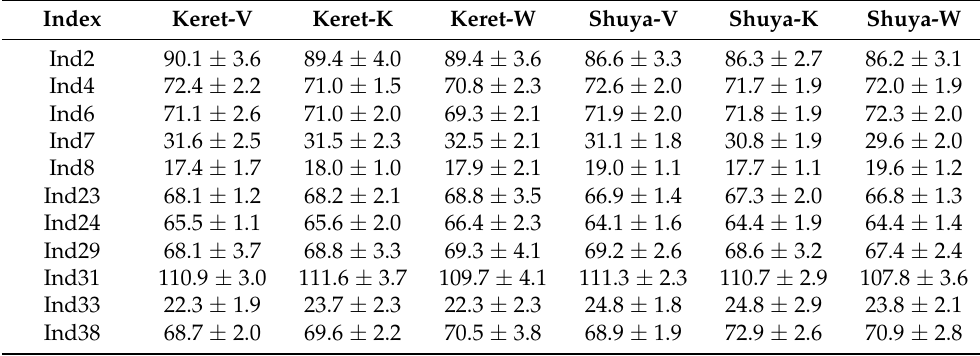
Table 3. Mean cranial bone indices (mean ± std. dev.) in the six juvenile Atlantic salmon samples examined in this work. The indices are designated as in Table